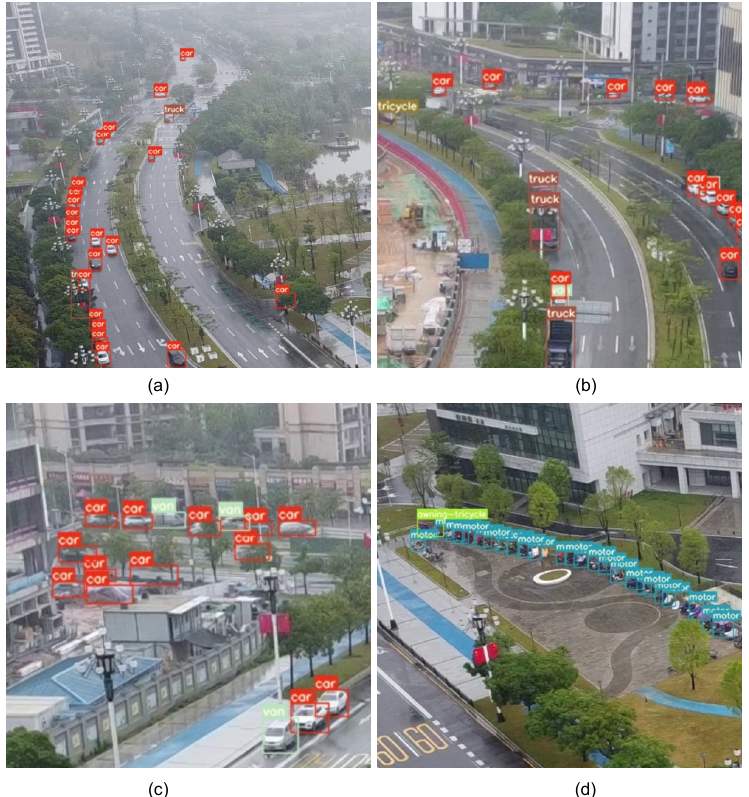
Figure 16. Visualization of the detection results obtained with CoDerainNet on our RainDrone dataset. These subfigures ( a ), ( b ), ( c ), and ( d ) are captured by drones in real rainy weather conditions.